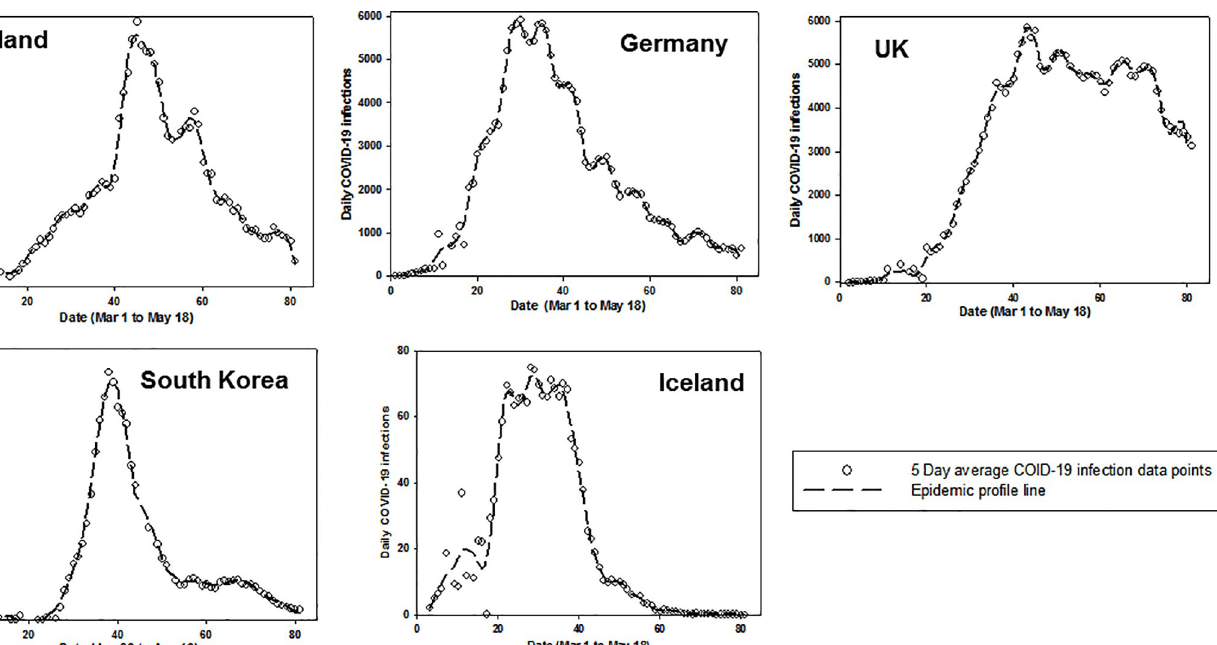
PLOS ONE | https://doi.org/10.1371/journal.pone.0250699 April 23,